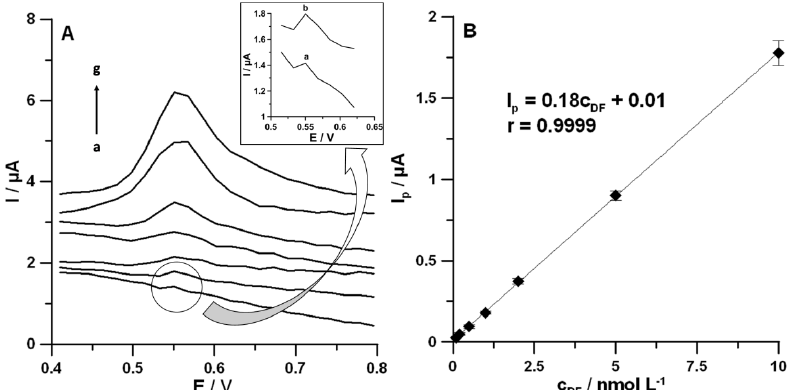
Figure 7. ( A ) DPAdSV curves recorded at the surface of the SPCE/MWCNTs-COOH in the NaAc–HAc buffer solution with a pH value of 4.0 ± 0.1 containing increasing concentrations of DF: (a) 0.1, (b) 0.2, (c) 0.5, (d) 1.0, (e) 2.0, (f) 5.0, and (g) 10.0 nmol L -1 . ( B ) Calibration graph of DF. The DPAdSV parameters: E acc of −0.25 V, t acc of 60 s, A of 125 mV, t m of 10 ms, and ν of 175 mV s −1 . Table 2. Characteristics of the calibration plot of DF obtained at the SPCE/MWCNTs-COOH surface. Parameter DPAdSV Linear range (nmol L − 1 ) 0.1–10.0